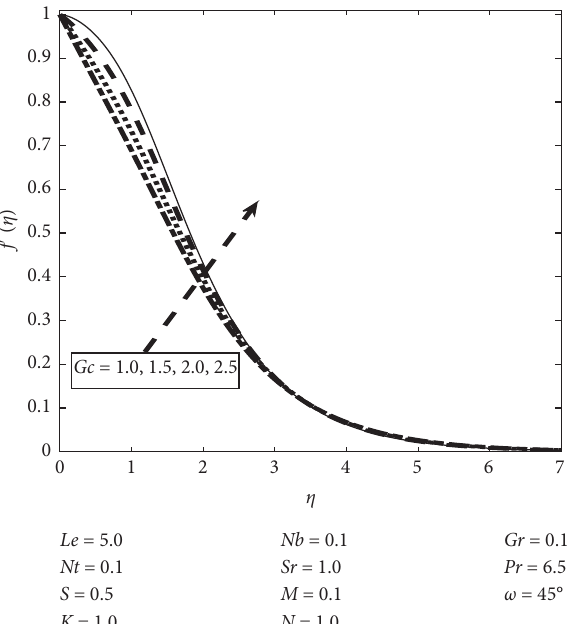
Figure 8: Velocity profile for several values of S .